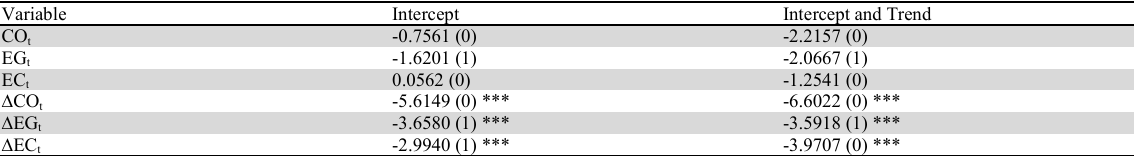
DF-GLS Unit Root Test